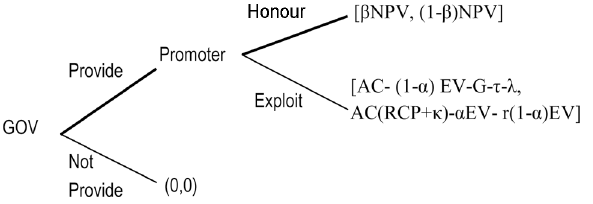
Fig. 4. The extensive form of GDG